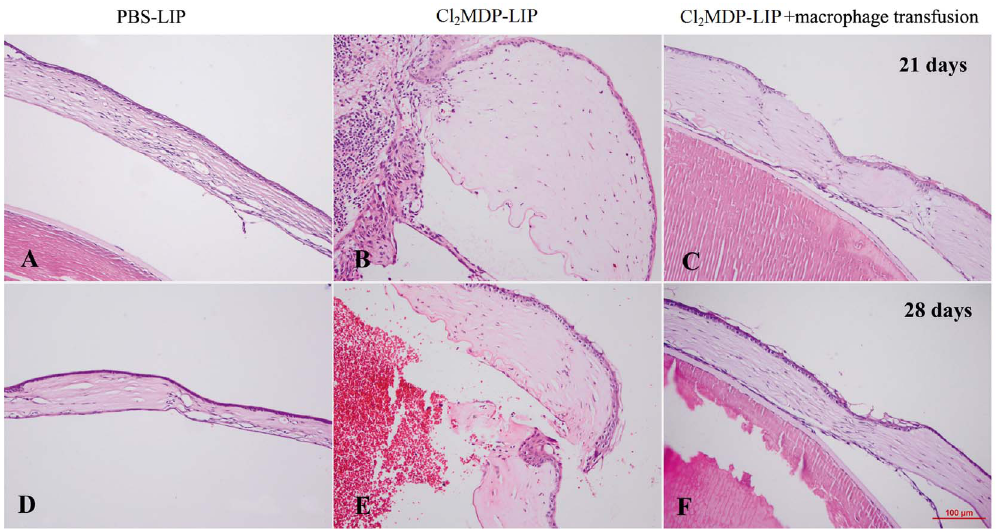
Figure 6. Effect of macrophage transfusion on corneal wound healing. Forty-eight hours after penetrating keratoplasty in mice injected with Cl 2 MDP-LIP, 10 5 peritoneal macrophages from naı¨ve Balb/c mice were transfused into conjunctiva. After 21 and 28 days later, the mice with macrophage transfusion into conjunctiva showed significant enhanced wound healing (C, F), almost similar to the control mice injected with PBS-LIP (A, D), while the macrophage-depleted mice still showed significant defective wound healing and even the disclosure of eye content (B, E).